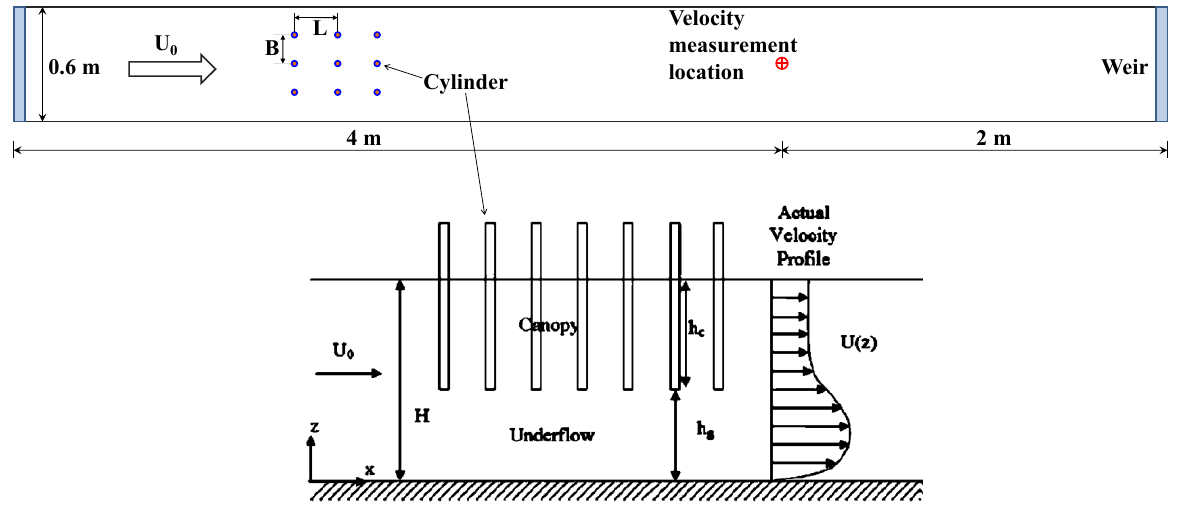
Figure 1. Schematic of the experimental flume setup (adapted from Plew [15], with permission from © 2011 American Society of Civil Engineers). Cylinders were arranged in rows with a spacing of L (m) in the direction of flow, and a transverse spacing of B (m) between cylinders. Velocity measurements were taken at a distance of 4 m from the inlet. H (m) is the total water depth in the flume, h (m) is the canopy height, and h (m) is the c g distance between the canopy and the flume bed.